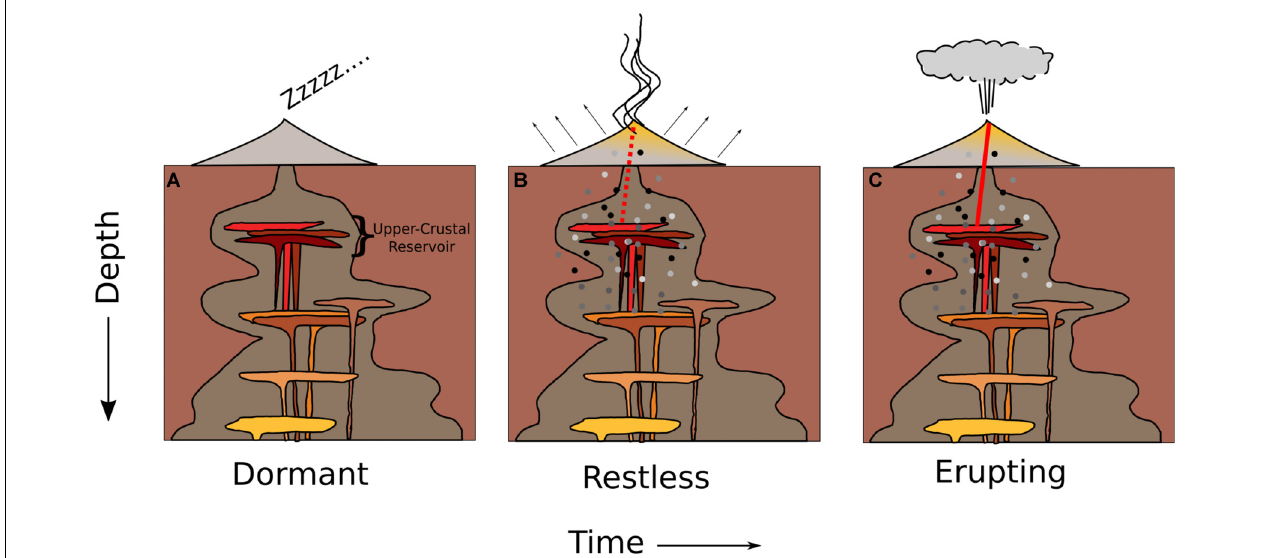
FIGURE 1 | Cartoon illustrating three possible states of a volcanic system (e.g., Sparks and Cashman, 2017). (A) A dormant volcano may be underlain by stagnant magma but no conduit exists. This state may be accompanied by no or low rates of seismicity and gas emissions. Although not illustrated, this state also encompasses deep vertical transfers of magma. (B) Prior to eruption, a conduit must be formed. This process is assumed to be characterized by a ‘restless’ state involving elevated rates of seismicity, deformation, and gas emissions. In some cases, conduit formation begins but is never completed, leading to a “failed eruption” (Moran et al., 2011). (C) If a through-going conduit is formed, magma ascends to intersect the surface and erupt.